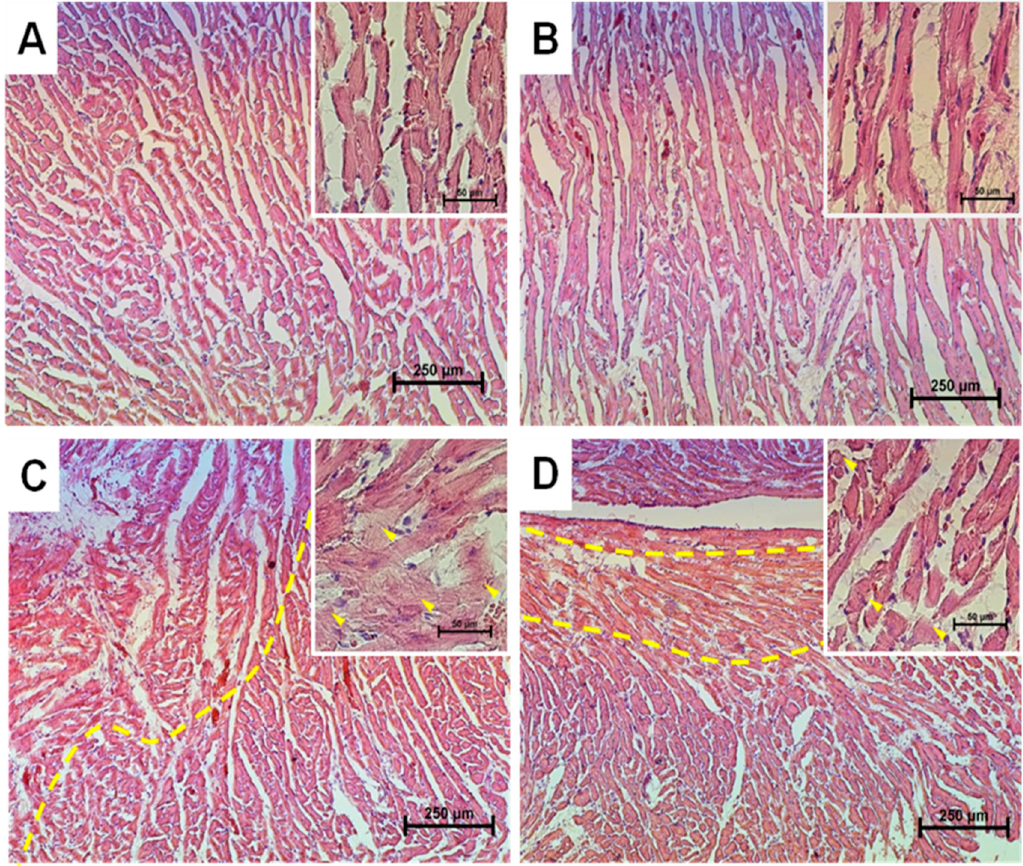
Figure 1. Histological preparations of the left ventricles from different groups of rats. ( A ) Control animals; ( B ) animals treated with melatonin (MEL) (~7 mg/kg of body weight per day); ( C ) animals treated with isoprenaline hydrochloride (ISO) (85 mg/kg of body weight twice); ( D ) animals treated with MEL + ISO. The yellow stroke restricts the area of degenerative changes. The foci of granular dystrophy are indicated by yellow arrows.